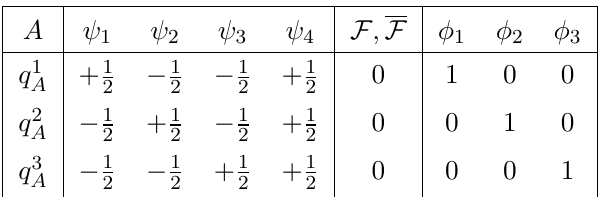
Table 1 . The charge vectors of the di(cid:11)erent (cid:12)elds in (cid:13) -twisted N =4 SYM, cf. (2.1). Conjugate (cid:12)elds have the opposite charges. Gauge (cid:12)elds do not carry and derivatives do not add charge. D is identical for N = 4 SYM [21] and all its deformations. In this paper, we are inter- 0 ested in the one-loop contribution to (cid:14) D , which we identify with the Hamiltonian H of a spin